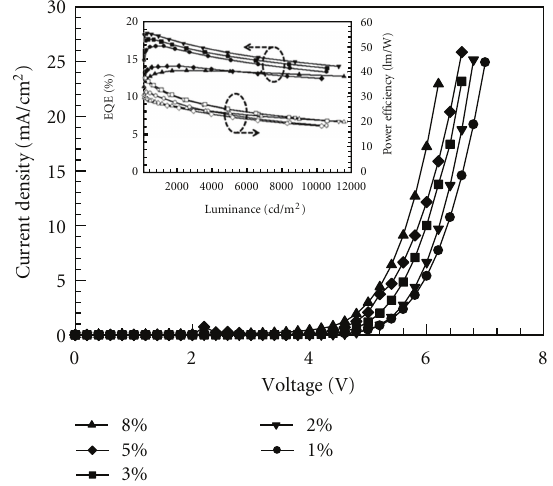
Figure 8: J - V characteristics of CBP:Ir(ppy) 3 green PHOLEDs with doping concentration from 1 to 8%. Inset shows the EQE and power e ffi ciency as a function of